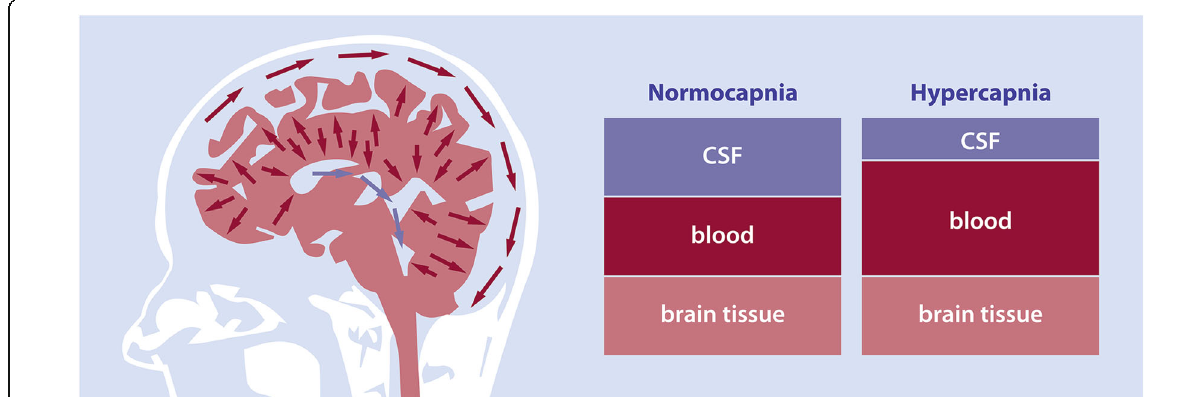
Fig. 1 Schematic illustration of the Monro-Kellie doctrine. The Monro-Kellie doctrine describes the dynamic relationship between the intracranial cerebrospinal fluid (CSF), blood, and brain volumes to maintain intracranial pressure. The left panel displays the CSF displacement invoked by an increased cerebral blood volume during hypercapnia. As well, flow in the superior sagittal sinus is shown. Here, CSF is absorbed through the subarachnoid villi. The middle panel is an illustration of the intracranial compartment during normoxic normocapnia. The right panel shows the intracranial volume during hypercapnia, when blood volume increases and CSF volume